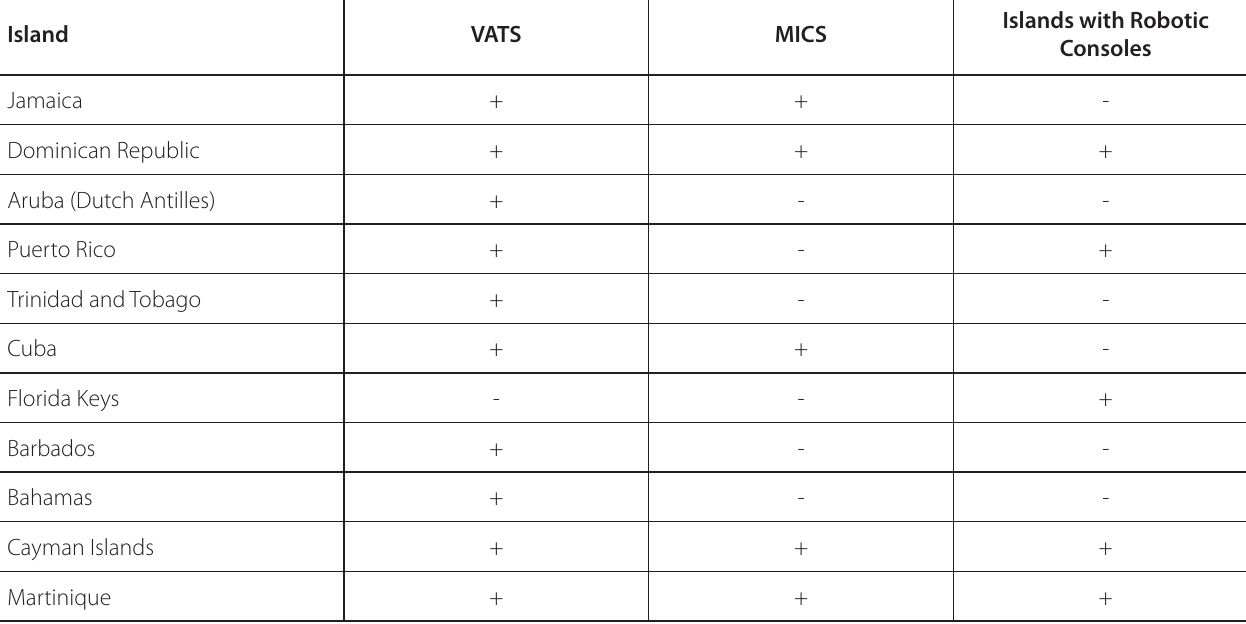
Table 3 . Caribbean islands performing minimally invasive cardiac and thoracic surgery.